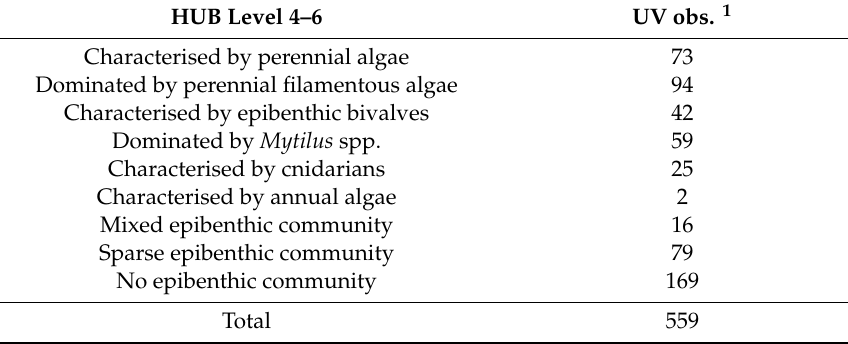
Table A5. Distribution of the ground-truth dataset divided into HUB 4–6 classes. HUB Level 4–6 UV obs.